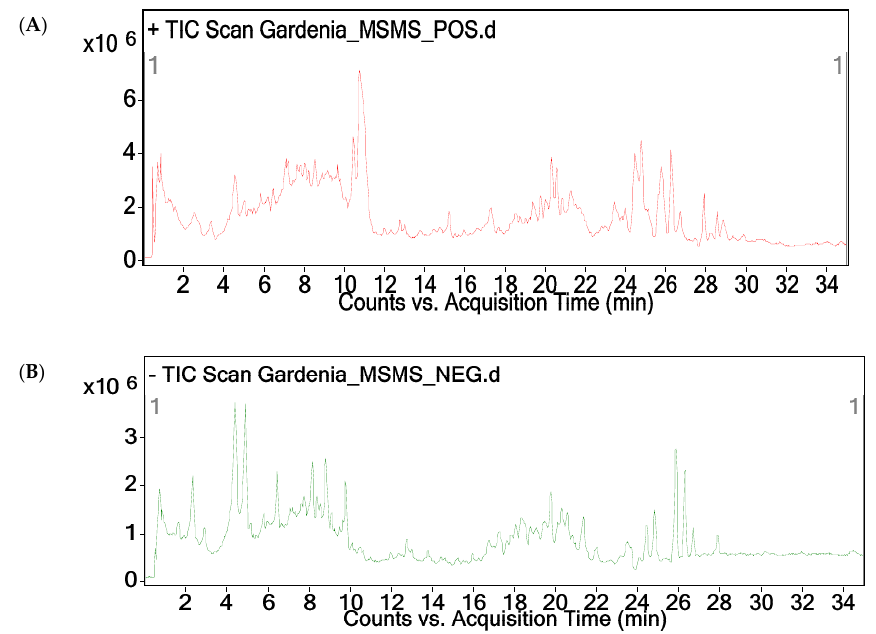
Figure 2. LC-MS/MS spectrum of methanolic fruit extract of G. latifolia (A) Chromatogram of fruit extract of G. latifolia on positive ionization mode. (B) Chromatogram of fruit extract of G. latifolia on negative ionization